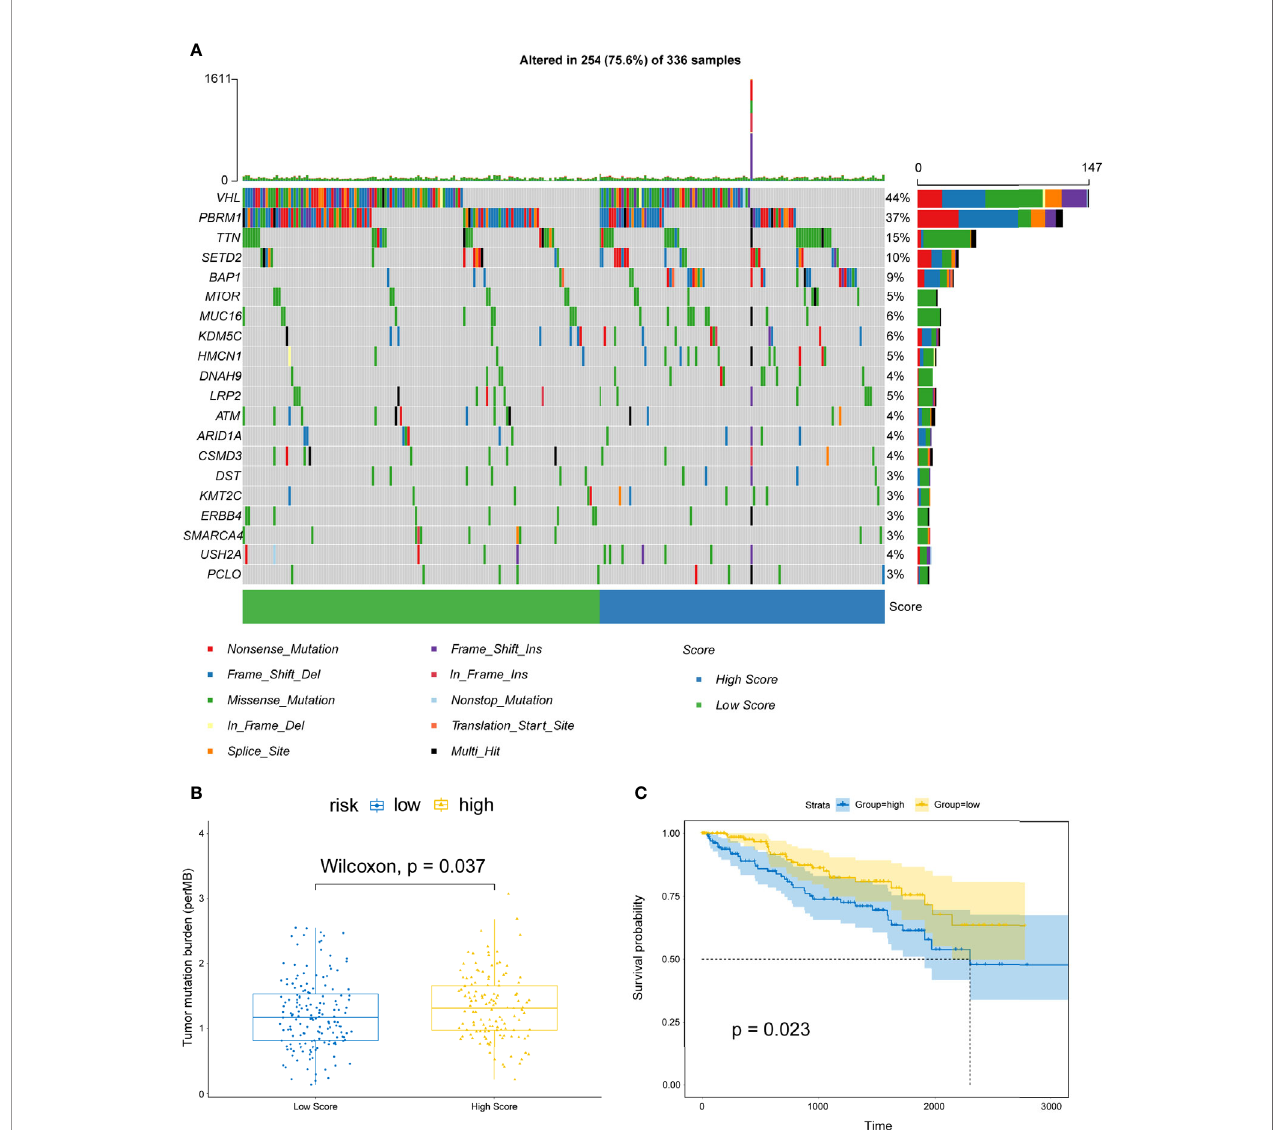
FIGURE 12 | Correlations between risk scores and TMB. (A) OncoPrint displays the mutation pro fi le of top 20 frequently mutated genes. Each column represents individual patients and mutated genes arranged by mutation rates. The right shows the mutation percentage, and color-coding indicates the mutation type. (B) Boxplot shows the difference of TMB between high- and low-risk patients. (C) Kaplan – Meier curves for OS divided by the high TMB group and the low TMB